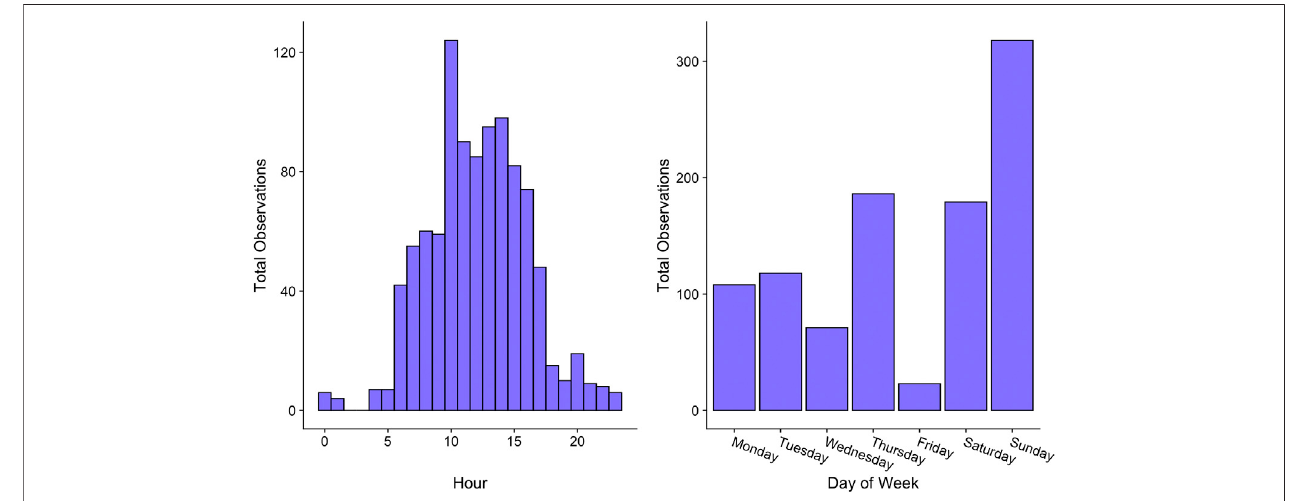
FIGURE 5 | Number of observations by hour (left) and day of the week (right)